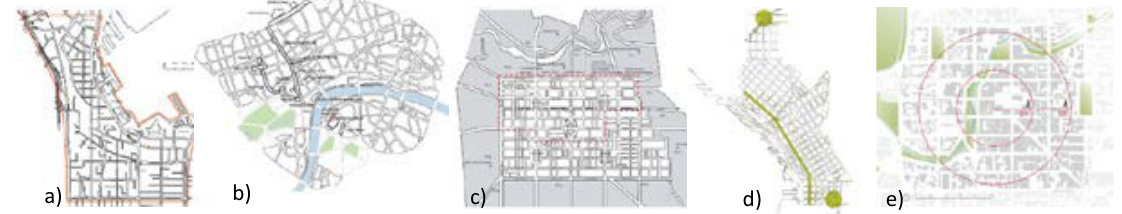
Fig. 1: Projects Study Areas from left to right (Wellington, London, Adelaide, Seattle, and Christchurch), (Gehl,2002;2004;